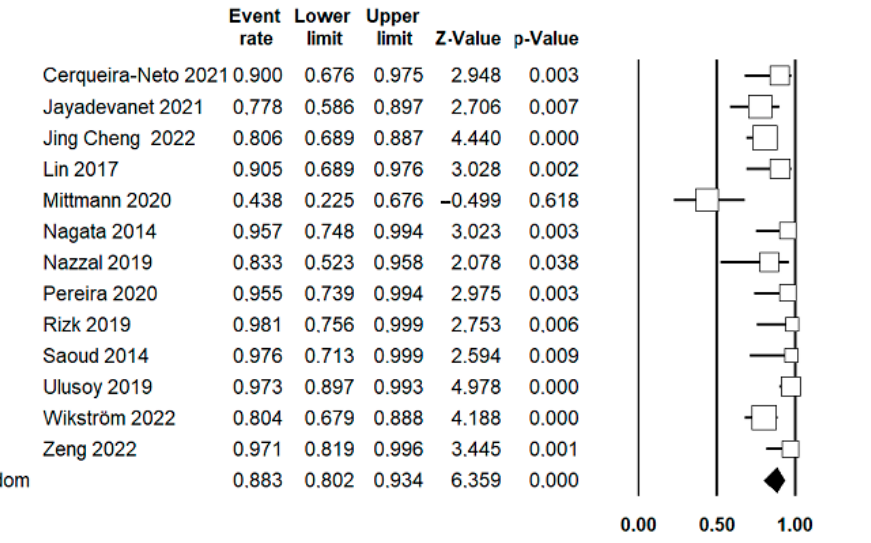
Figure 3. Forest plot of the estimated success rate of traumatized teeth treated with pulpal revascu- larization among the selected studies. Using a random-effects model where 13 studies, including 411 cases, were combined to estimate the success rate of RET [42-54 ].